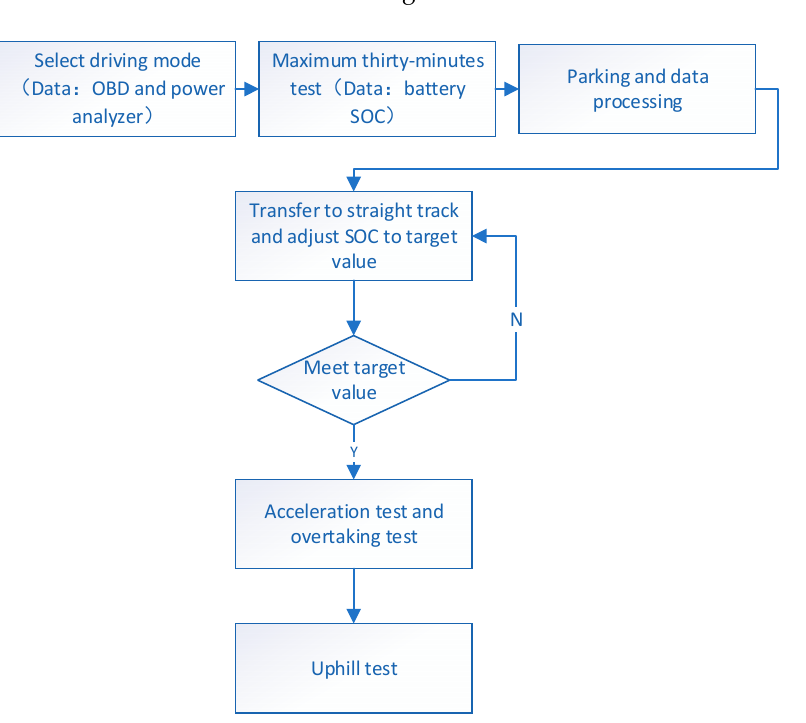
Figure 2. Maximum thirty-min speed test results.